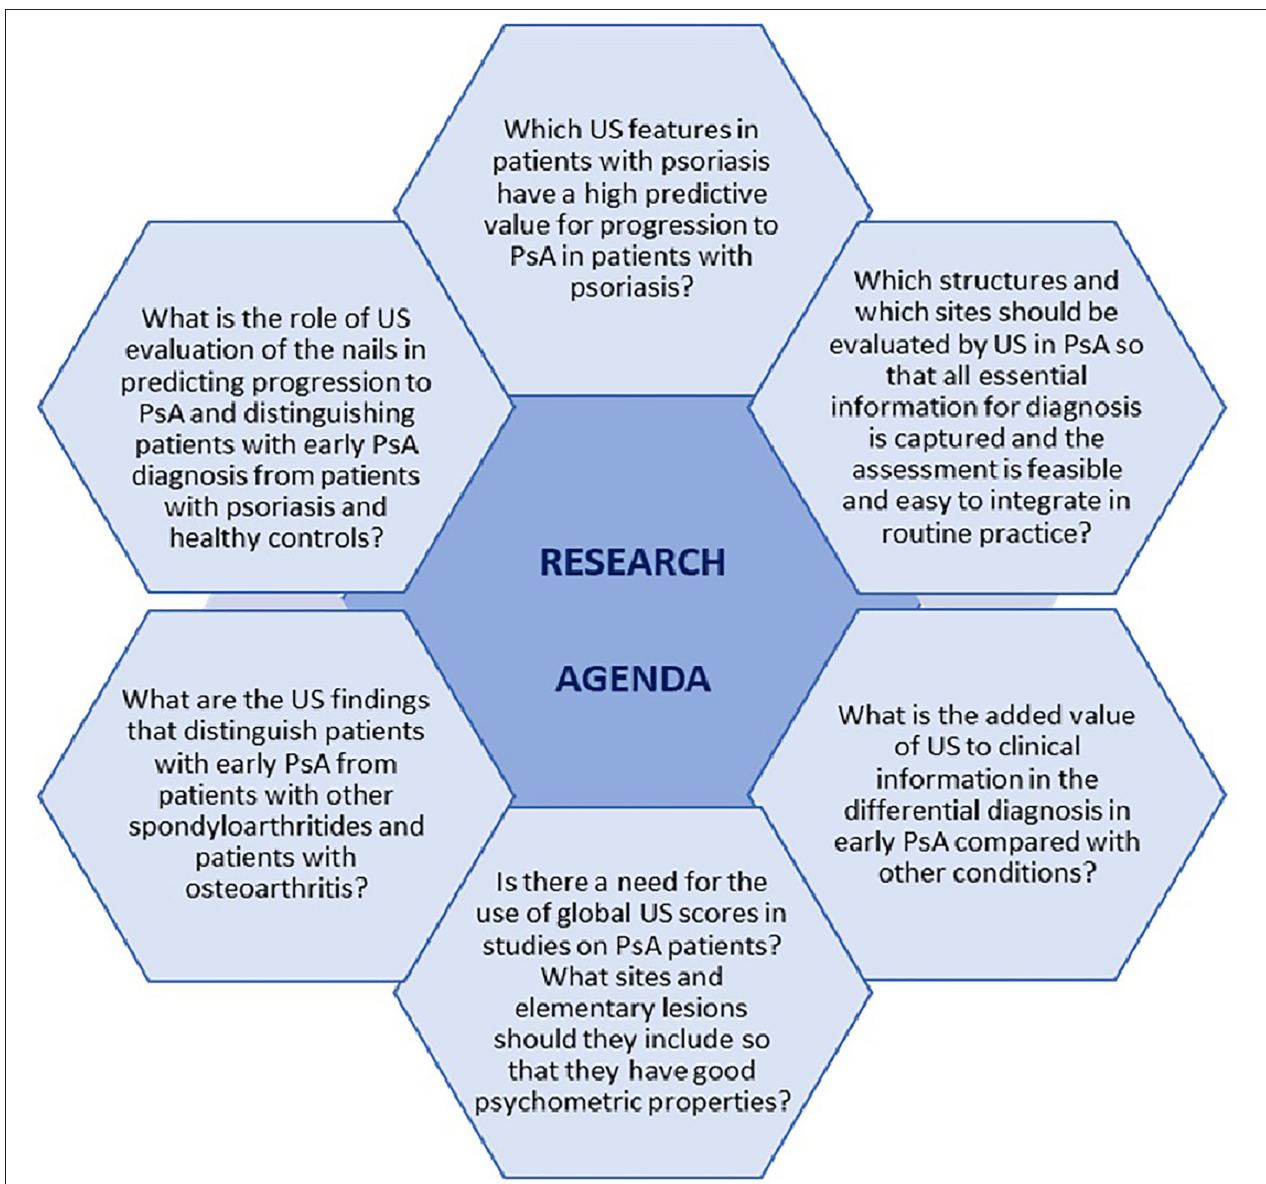
FIGURE 1 | Research agenda for the use of ultrasound in early psoriatic arthritis.